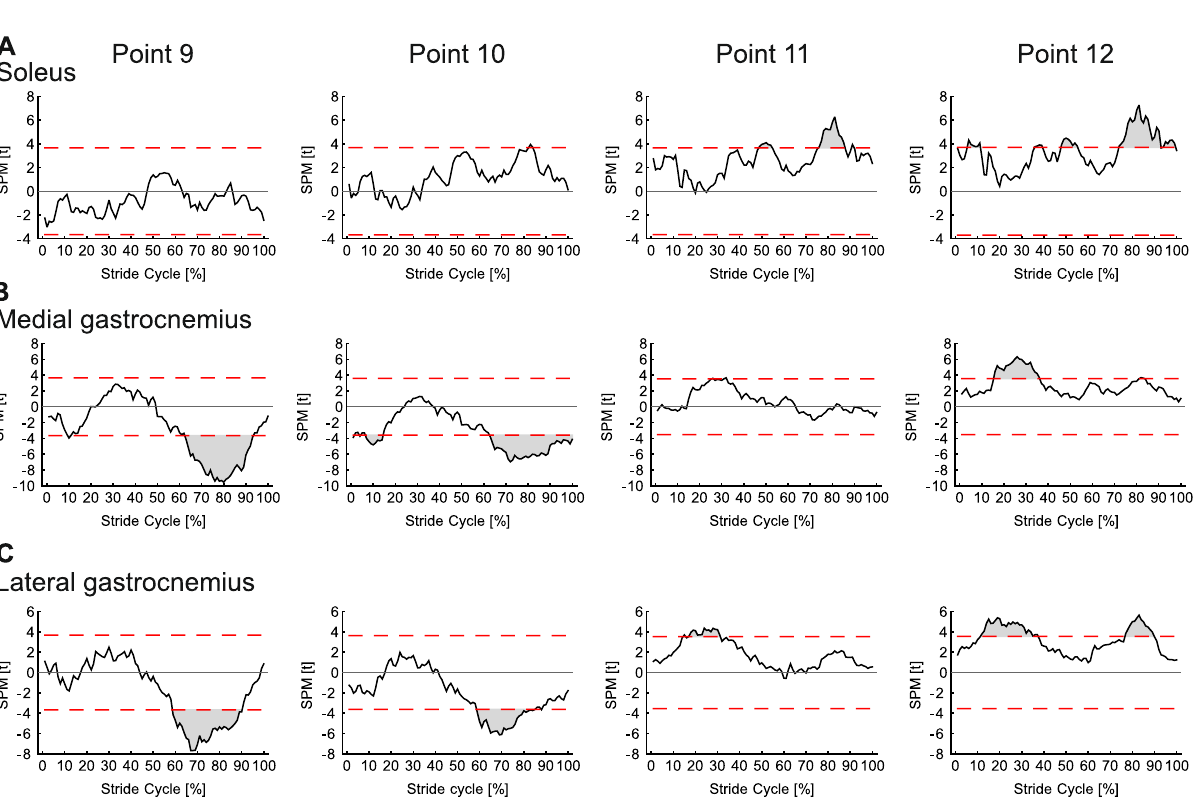
Figure 4. SPM paired t-test results comparing thickness muscle values at different central image points to the mean thickness. Columns represent the different muscle region comparisons for each row: ( A ) soleus, ( B ) medial gastrocnemius, ( C ) lateral gastrocnemius. See Fig. 1 for point positions in ultrasound